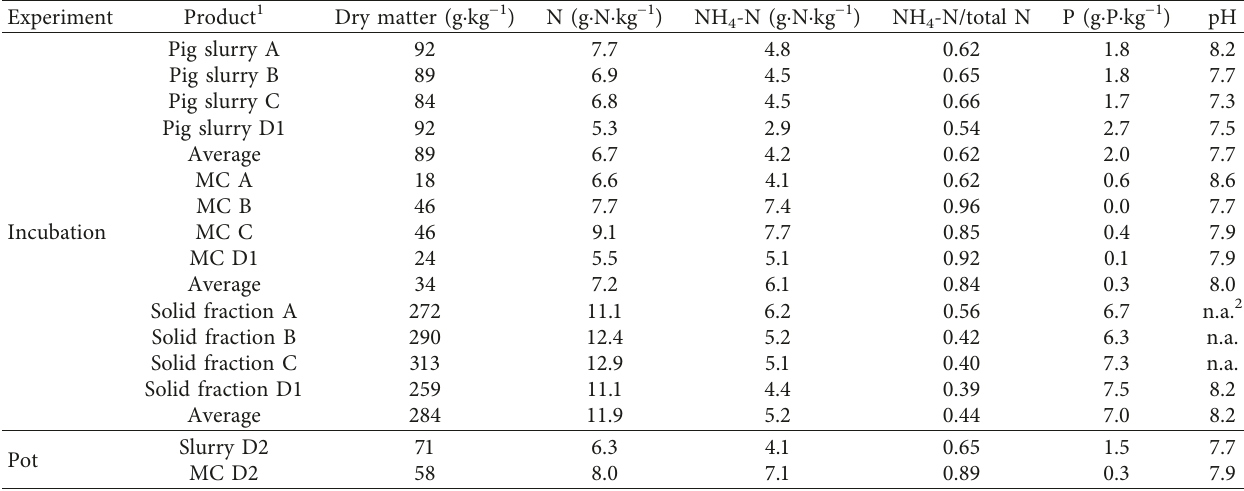
Table 1: Composition of the tested products (expressed on basis of fresh